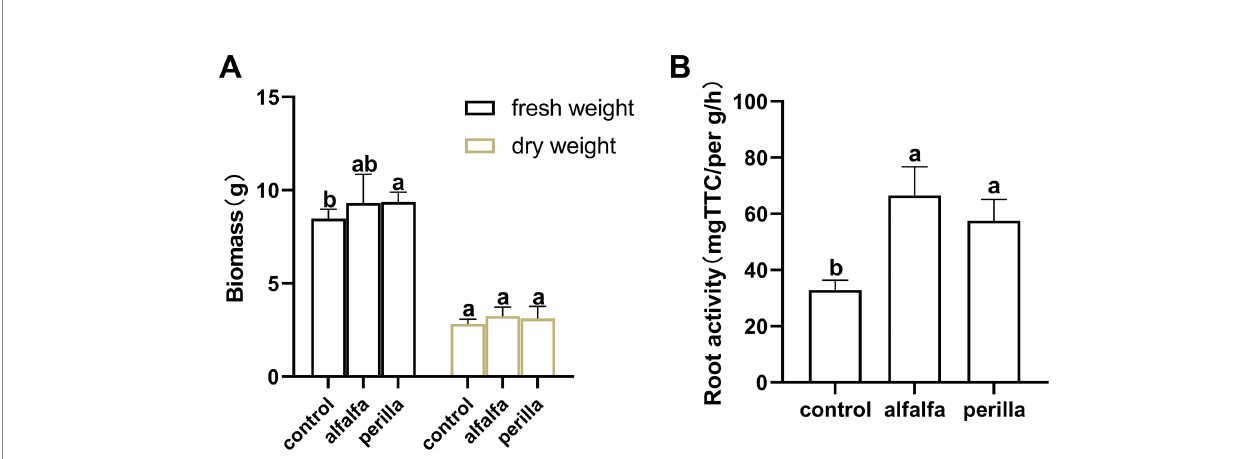
FIGURE 9 (A) Ginseng root biomass and (B) root activity in different treatments. Different letters indicate a significant difference at the p < 0.05 level. Control, no treatment; Alfalfa, alfalfa cultivation; Perilla, perilla